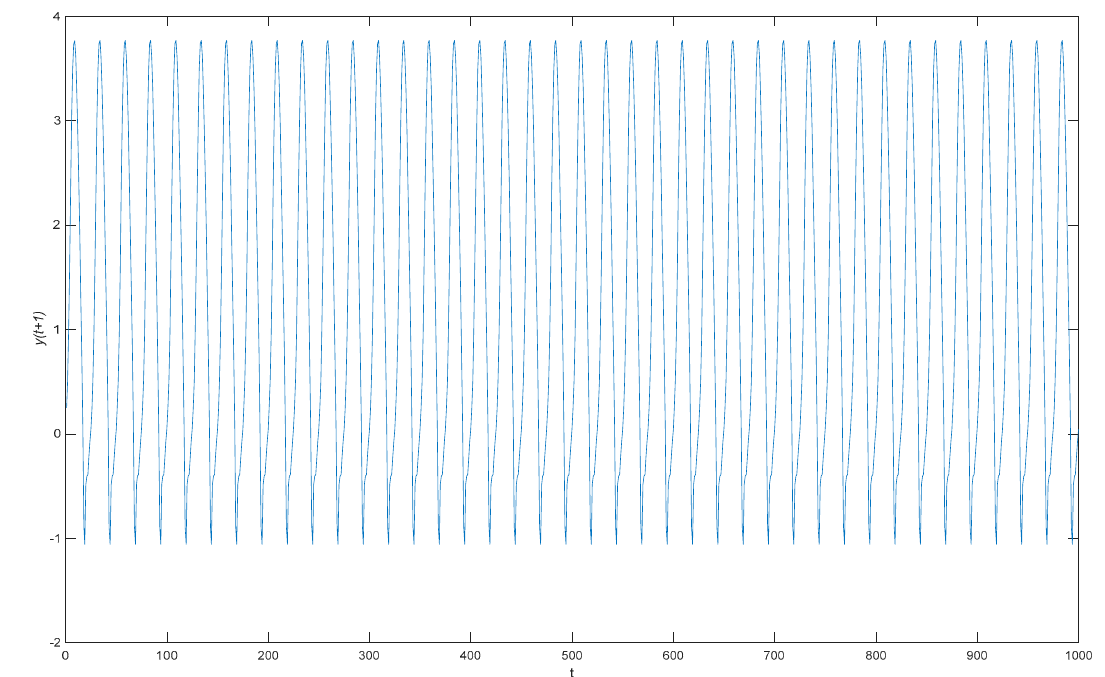
Figure 2. Input curve of ISCO-SVM model of nonlinear system.